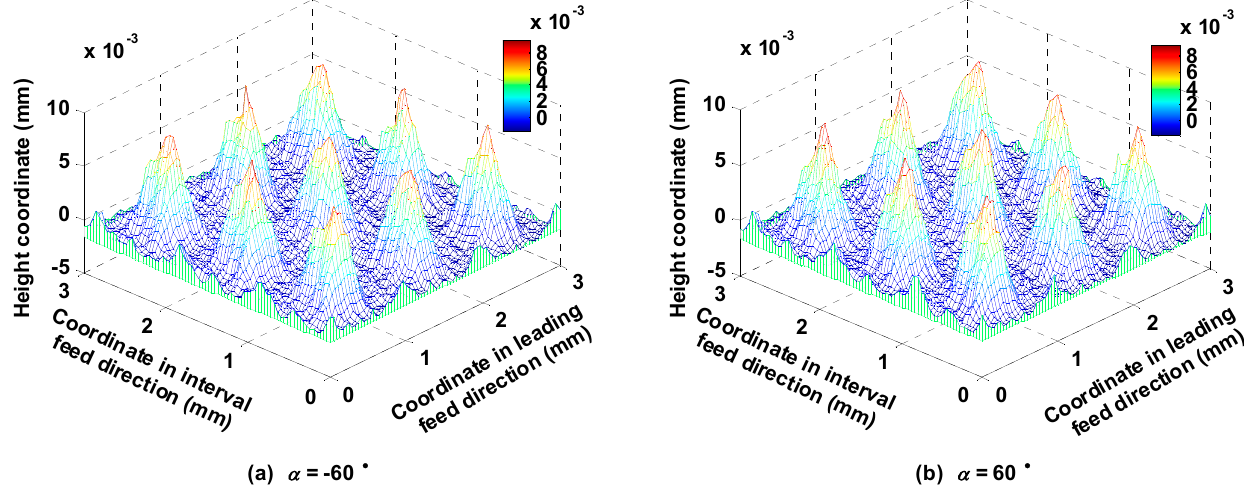
Figure 22. Ball-end trochoidal milled micro surface topography comparison between different tilt angles.